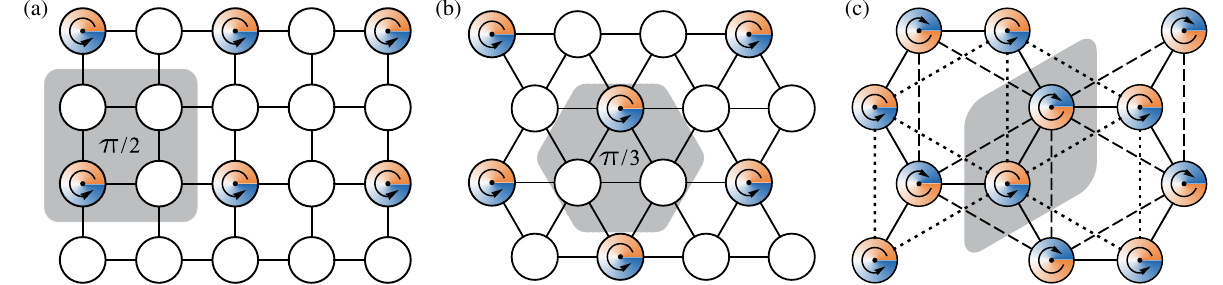
FIG. 3. Implementations of topological band structures described in the main text. (a) Hofstadter model with α ¼ 1 = 4 : A square, four-site, unit cell has one ferrite and three fundamental resonators. In the effective model near a frequency ω 0 , the ferrite induces a quarter flux quantum for each of the four neighboring plaquettes. (b) Triangular Hofstadter model with α ¼ 1 = 6 : A triangular lattice with a three-site unit cell has a single ferrite. This ferrite touches each of six neighboring plaquettes. (c) Haldane model: A hexagonal lattice has a ferrite on each lattice site. By staggering the handedness of the dark modes on A and B sublattices, the net flux vanishes. Addition of next-nearest-neighbor tunneling terms breaks time-reversal symmetry by inducing a flux of α ¼ (cid:2) π = 3 in each sublattice.